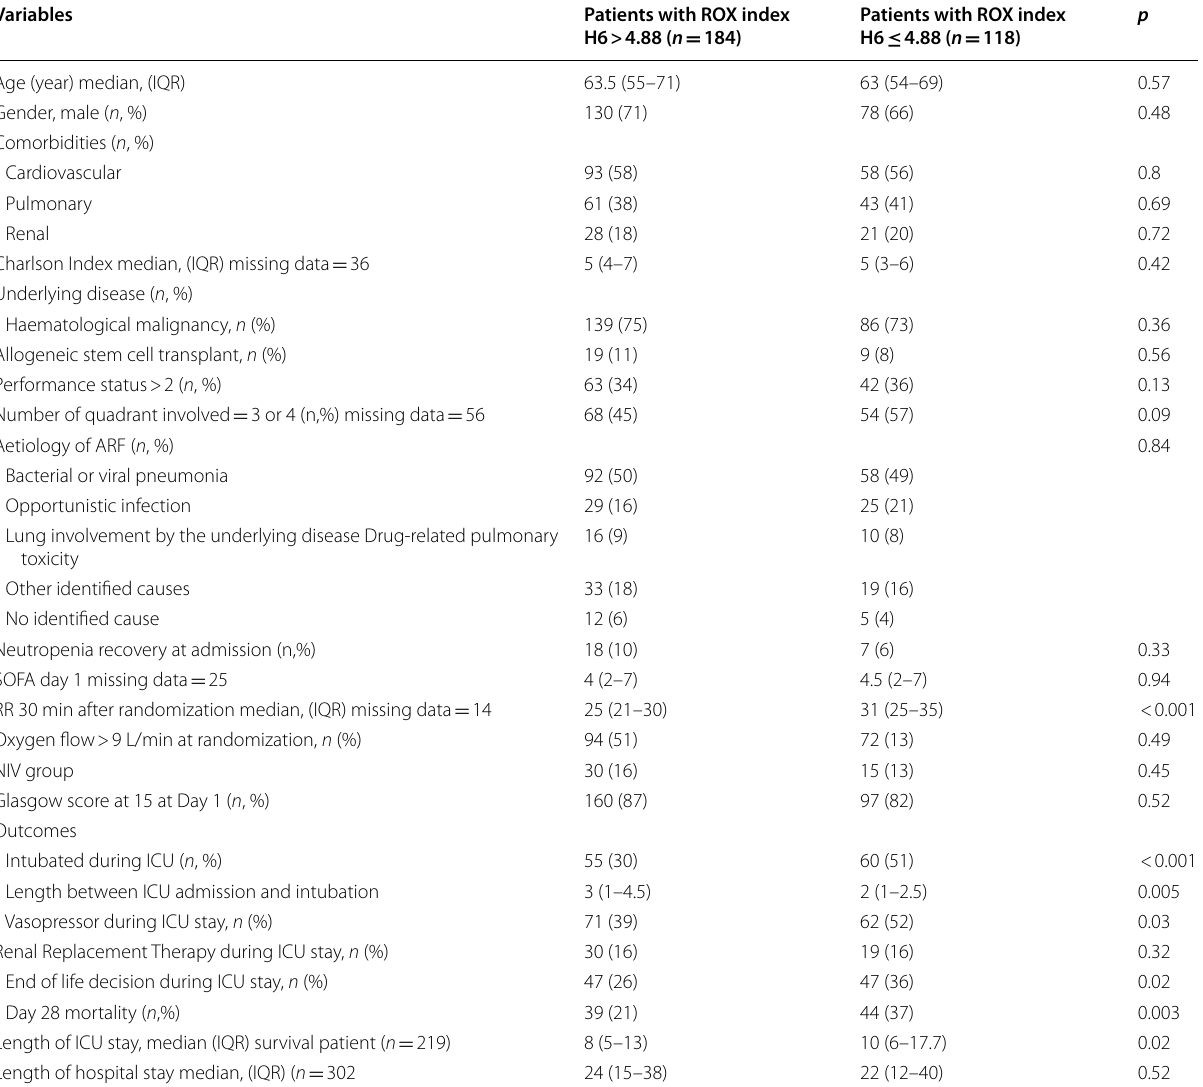
Table 2 Characteristics and outcomes based on ROX index over or under 4.88